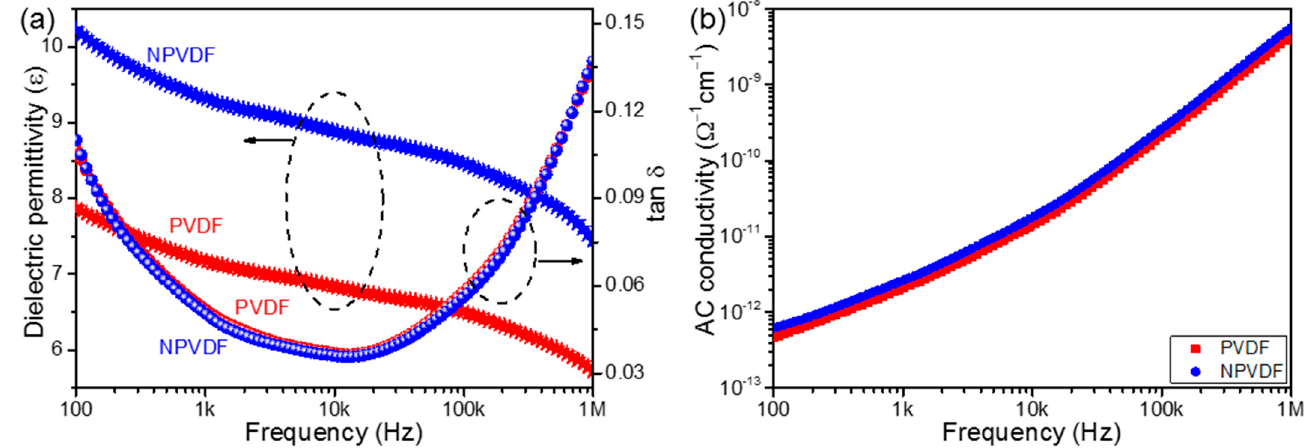
Figure 7. Frequency -d ependent ( a ) dielectric permi tt ivity and tan δ and ( b ) AC conductivity of the Figure 7. Frequency-dependent ( a ) dielectric permittivity and tan δ and ( b ) AC conductivity of the fabricated composite fi lms. fabricated composite